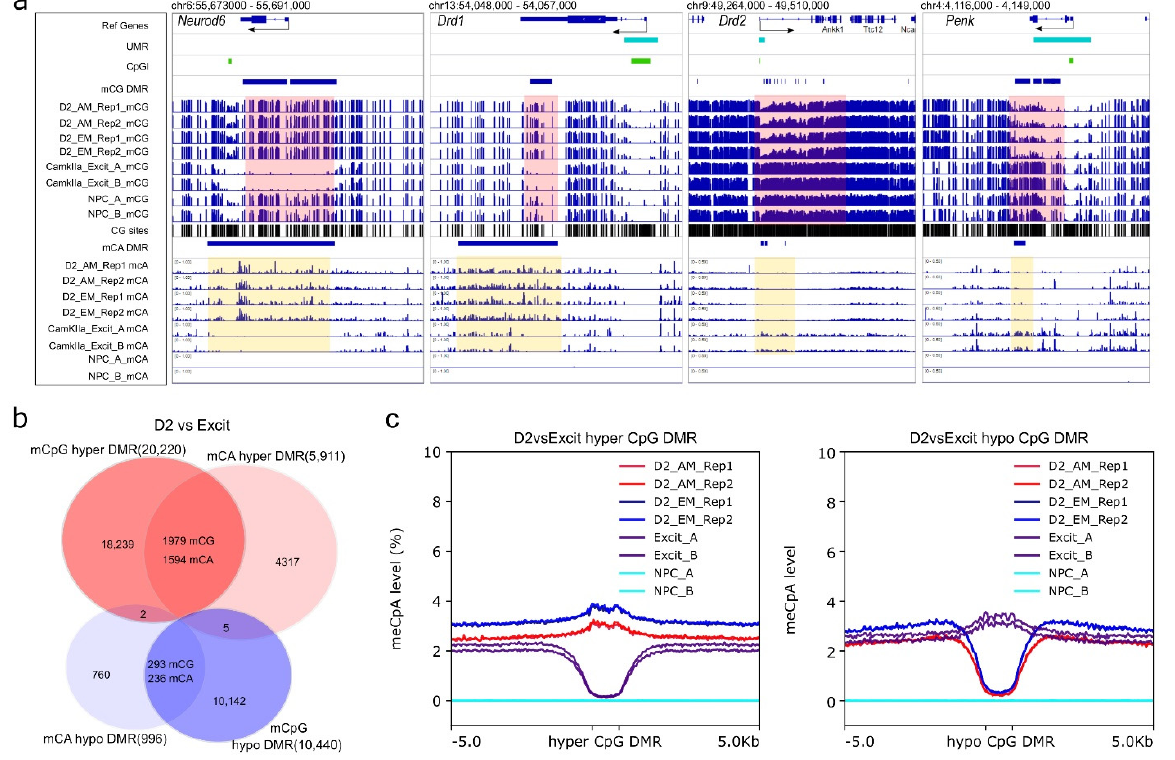
Figure 5. NAc D2-MSN-specific non-CpG DMRs. All non-CpG DMRs are identified by comparing NAc D2-MSNs to PFC CamKIIa+ excitatory neurons (D2 vs. Excit). ( a ) Representative view of Drd1 and Neurod6 loci with CpG and CpA hypermethylation in D2-MSNs. In contrast, D2-MSN marker genes Drd2 and Penk have CpG and CpA hypomethylation along their genomic loci when compared to PFC CamKIIa+ excitatory neurons. Pink-shaded regions highlight CpG DMR regions, yellow-shaded regions highlight CpA DMR regions. β value range of all CpG lanes is 0–1. β value range of CpA for Neurod6 and Drd1 is 0–1. β value range of CpA for Drd2 and Penk is 0–0.5. NPC has virtually no CpA methylation. ( b ) CpG DMRs and CpA DMRs are significantly overlapped. ( c ) CpA methyl- ation levels at CpG DMRs. Left: CpA methylation levels of D2 hyper-methylated CpG DMRs (blue and red) are noticeably higher than surrounding regions in D2-MSNs and much lower in PFC ex- citatory neurons (purple). Right: The CpA methylation levels of D2 hypo-methylated CpG DMRs are much lower in D2-MSNs (blue and red) and are discernibly higher in PFC excitatory neu- rons(purple) compared to the adjacent regions. The NPC methylome is devoid of non-CpG methyl- ation (cyan).